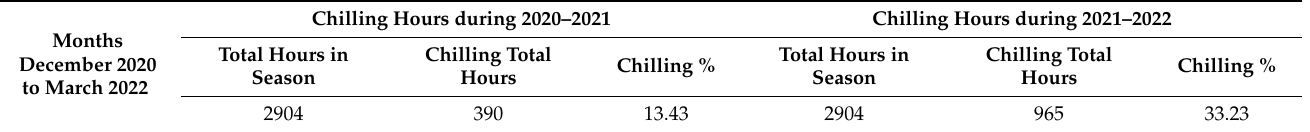
Table 2. Chilling hours from December 2020 to March 2022.